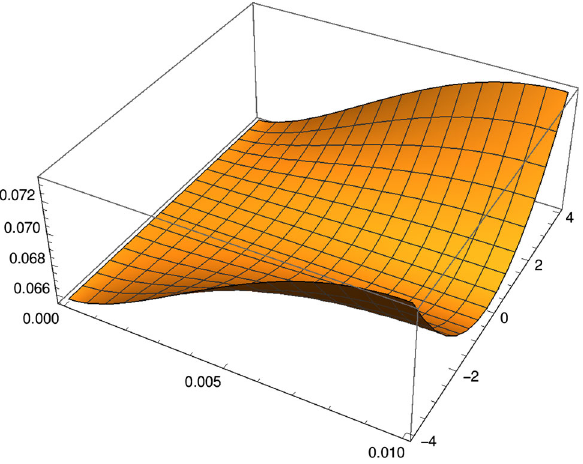
Fig. 8 3D plot of r vs (cid:13)/ H 0 and μ 2 /((cid:13) M ) for κ H 0 ∼ 0 . 01 and N = 60